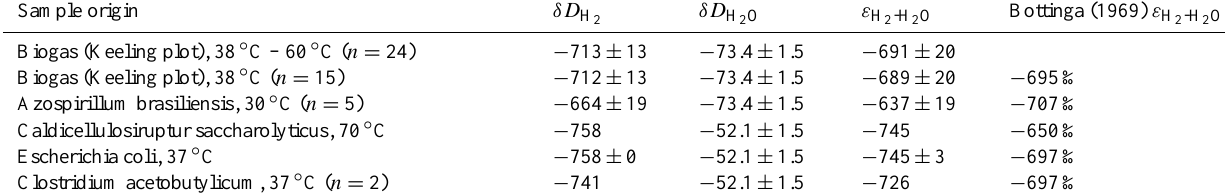
) , and isotopic 2 O